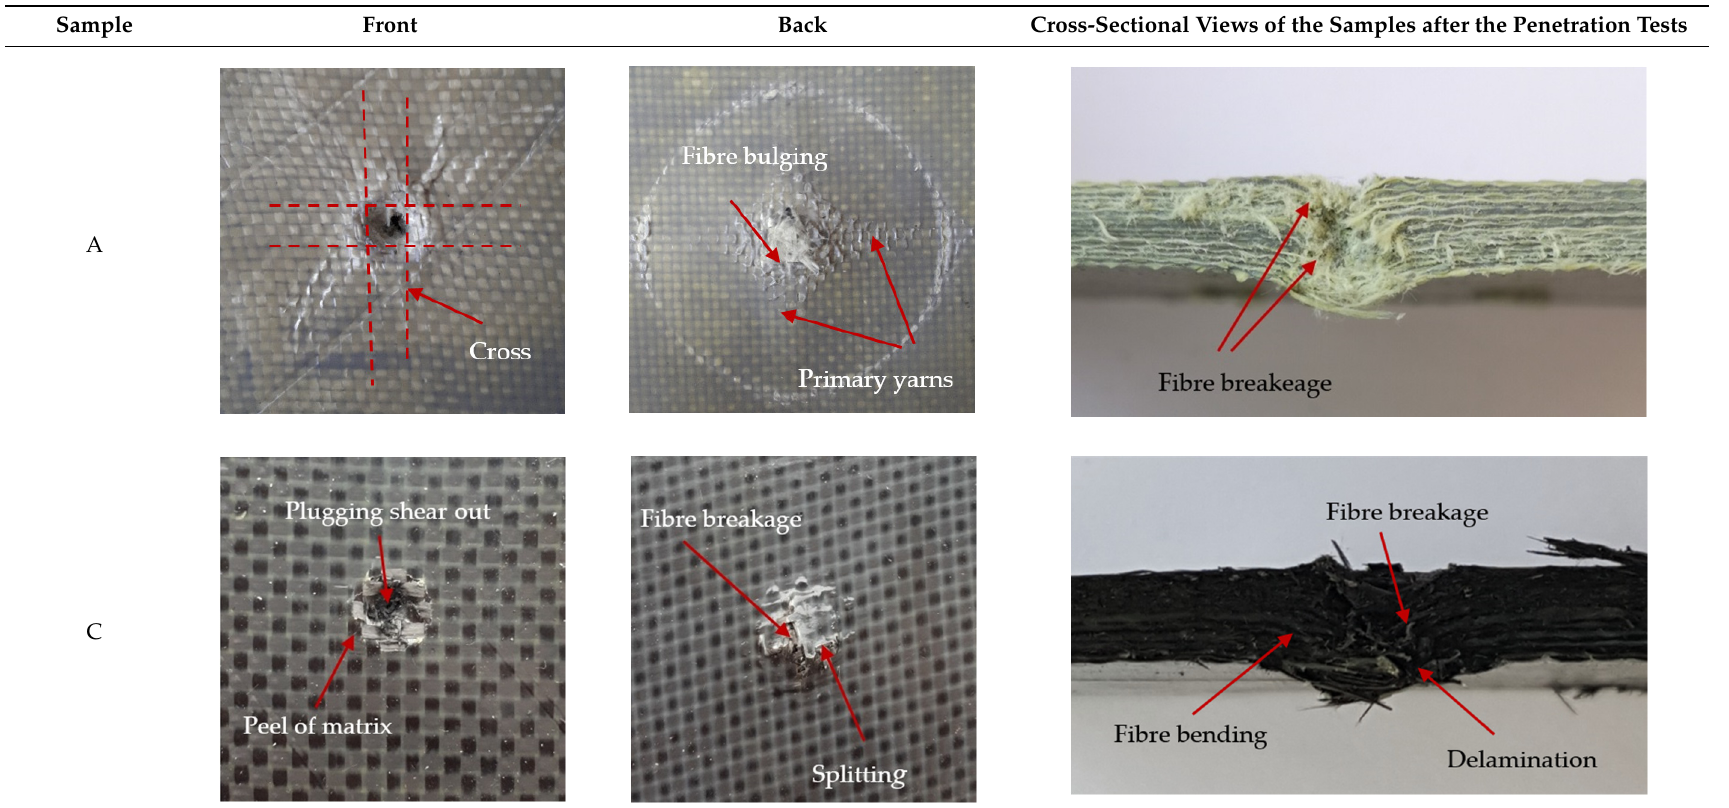
Table 4. Front and back views of the samples after the penetration tests.